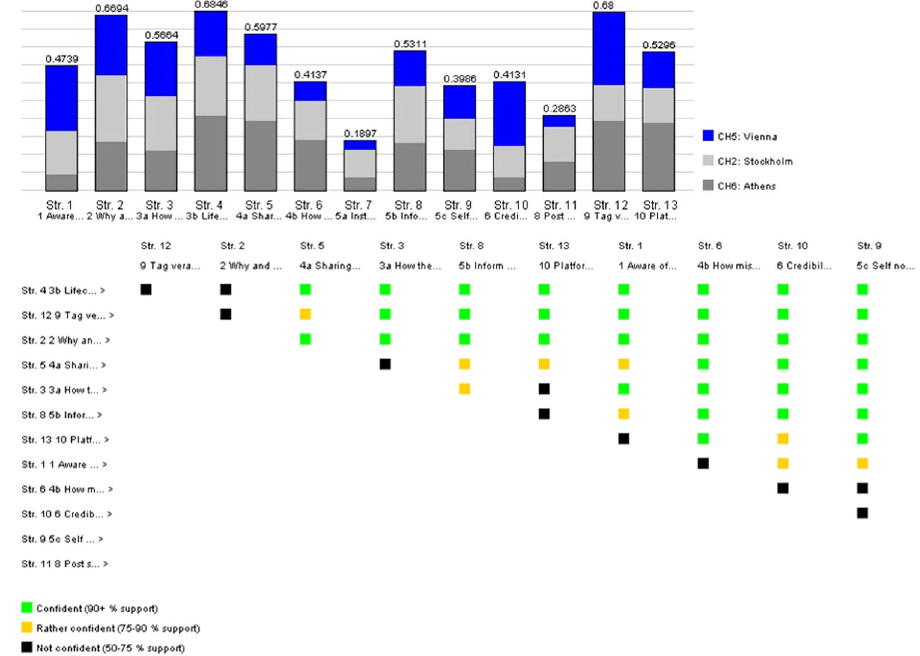
Fig. 3 Journalists preferences in Vienna, Stockholm and Athens. Preferences. Table 4 Policymaker preferences in Vienna and